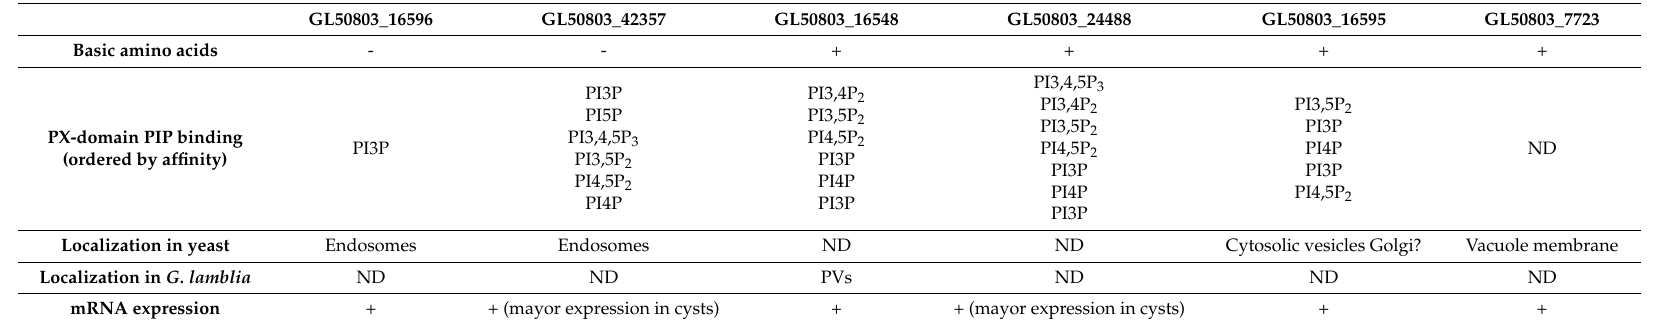
Table 1. The phagocyte oxidase (PX) domain-containing proteins in Giardia lamblia , Assemble A: phosphoinositide-binding specificities, localization and expression. PIP: phosphoinositide; PVs: peripheral vacuoles; ND: not determined; mRNA: messenger